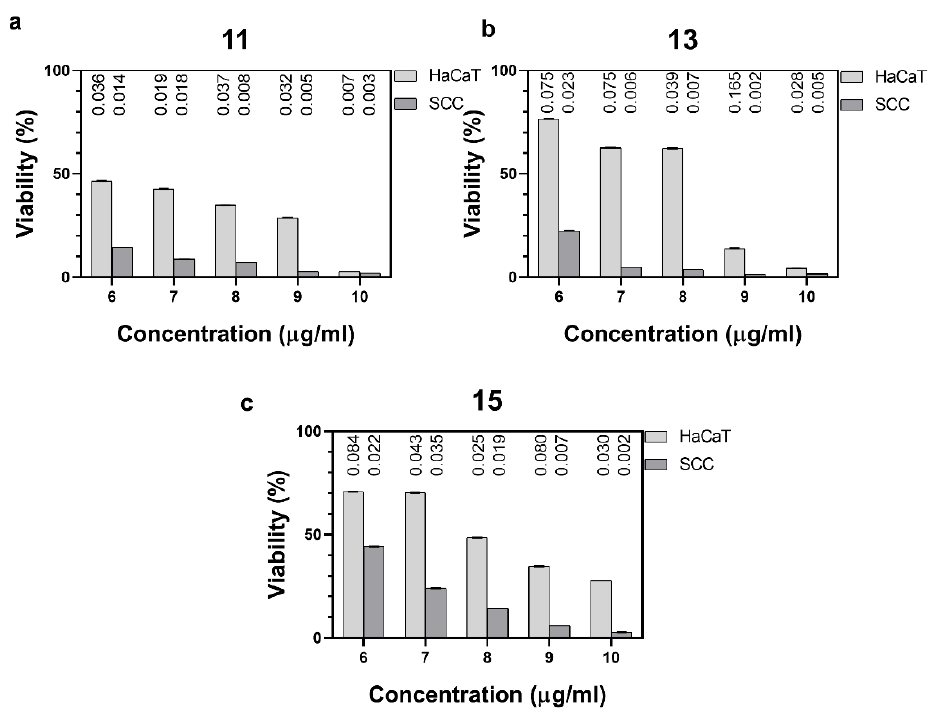
Figure 2. Effect of compounds 11 ( a ), 13 ( b ) and 15 ( c ) on viability of HaCaT and SCC cells by MTT assay.